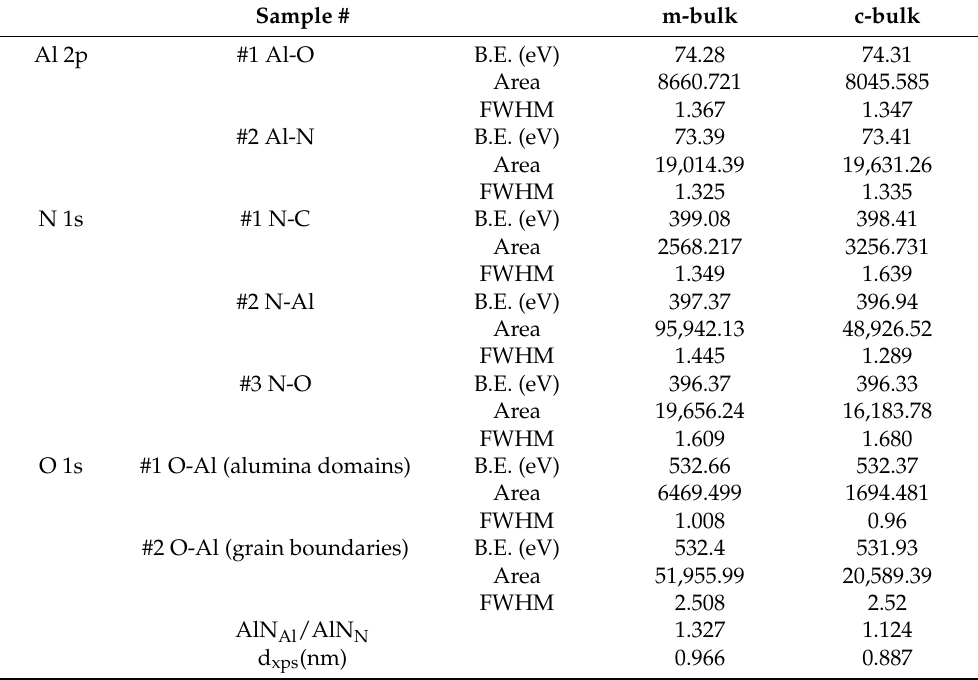
Table 1. XPS analysis result for two bulk AlN